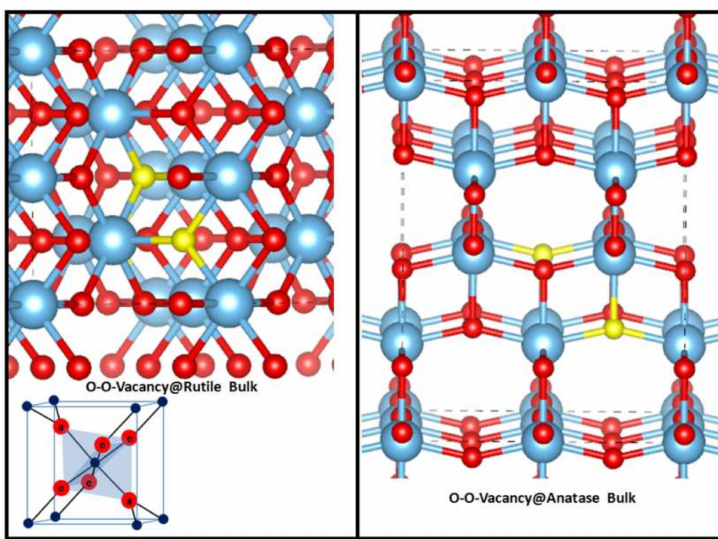
Figure 3. The most stable structures of O-O-vacancy@rutile and anatase bulk. The equatorial (e) and axial (a) O atoms around Ti atom in rutile structure have also been presented. Red and blue spheres represent O and Ti atoms, respectively, and yellow spheres represent O-vacancy